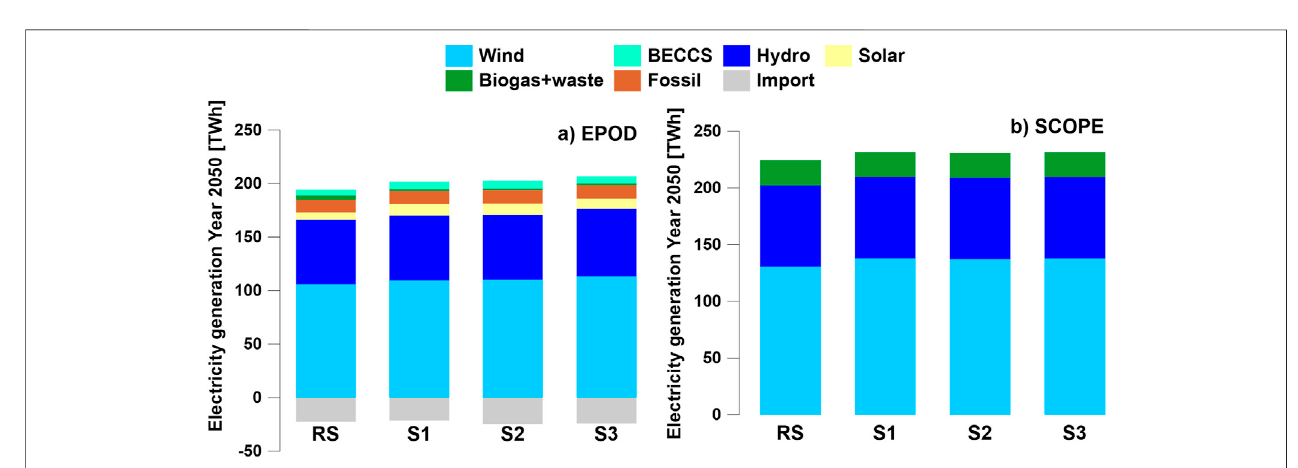
FIGURE 6 | Electricity generation in Sweden in Year 2050 for all scenarios, as predicted by (A) ELIN and (B) SCOPE.